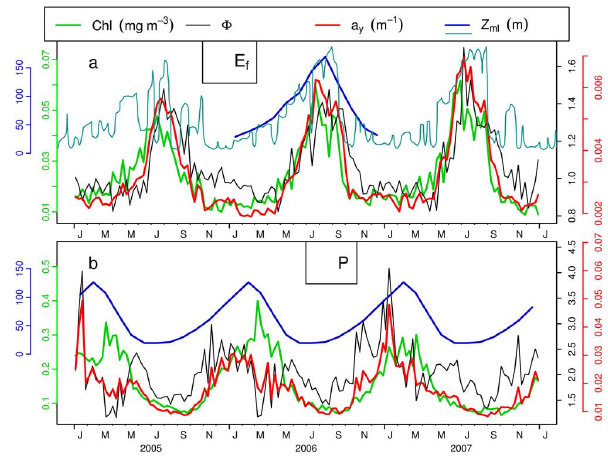
Fig. 6. (a) The three parameters, [Chl], a y (443), and 8 , are plotted with the same symbols and scales as in Fig.2, but they are com- puted from the 8-day SeaWiFS L3 composites, and for a sub-zone (109 ◦ –115 ◦ W, 24 ◦ –29 ◦ S) inside the E zone, where an ARGO float (WMO # 3000302) was deployed and has provided data at the 10- day frequency during the years 2005–2007. The depth (m) of the mixed layer ( Z ml ) was computed from the T-S data recorded by this float, and by using a density criterion ( 1σ = 0 . 03); the corre- sponding results are shown as the (thin) blue curve. The thick blue curve represents the Z ml values computed for the same zone from the climatology (de Boyer Montegut et al., 2004). (b) for the same years, [Chl], a y (443), and 8 are plotted also at 8-day resolution, for the zone “P” (off Portugal, see Tables 1 and 2). Note the change of scales between panel (a) and panel (b) (see also values in Table 2). The blue (thick) curve represents the climatological Z ml values for the “P” zone (from data in de Boyer Montegut et al.,